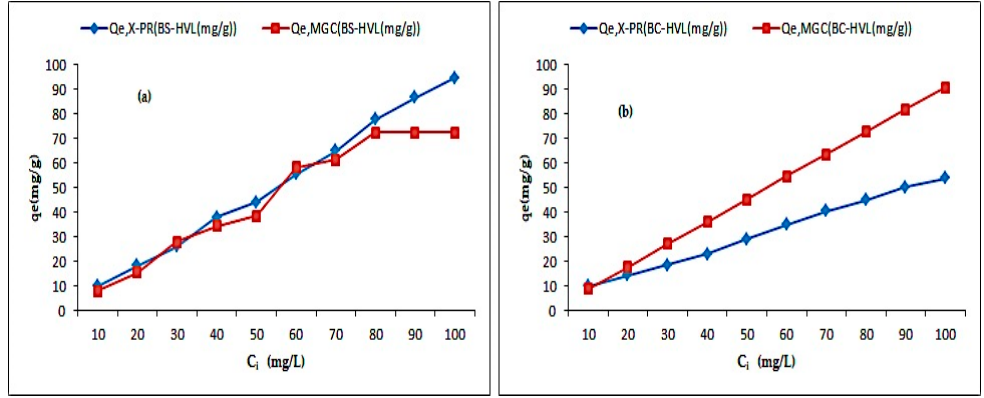
Figure 13. Effect of the initial dye concentration on the adsorption of X-PR and MGC by BS-HVL ( a ) and BC-HVL ( b ) (t = 90 min; T = 21 ± 1 °C; mad = 50 mg; stirring speed 150 rpm and pH = 7 ±0.3).